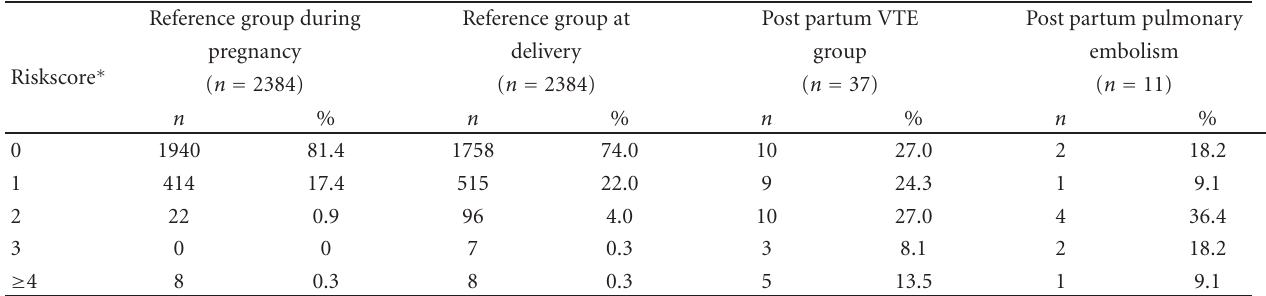
Table 4: Distribution of risk score ∗ in a pregnant population, at delivery [17], among women with postpartum VTE, or postpartum pulmonary embolism